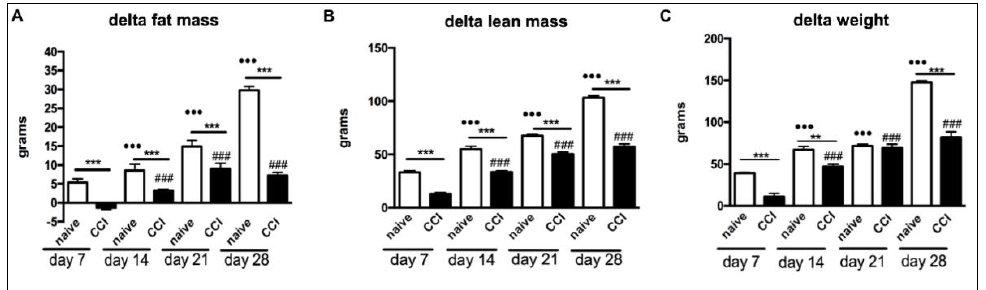
Figure 1. Effects of CCI of the sciatic nerve on weight and body composition. CCI animals showed a reduced increase in body weight, fat mass and lean mass compared to naïve rats. Variations in fat mass ( A ), lean mass ( B ) and body weight ( C ) are presented as the absolute difference between baseline values and the values observed every seven days after the intervention. The results are expressed as mean ± S.E.M. ••• : p < 0.001 vs. Naive day 7; ###: p < 0.001 vs. CCI day 7; **: p < 0.01 at 14 days; ***: p < 0.001 at 7 and 28 days.